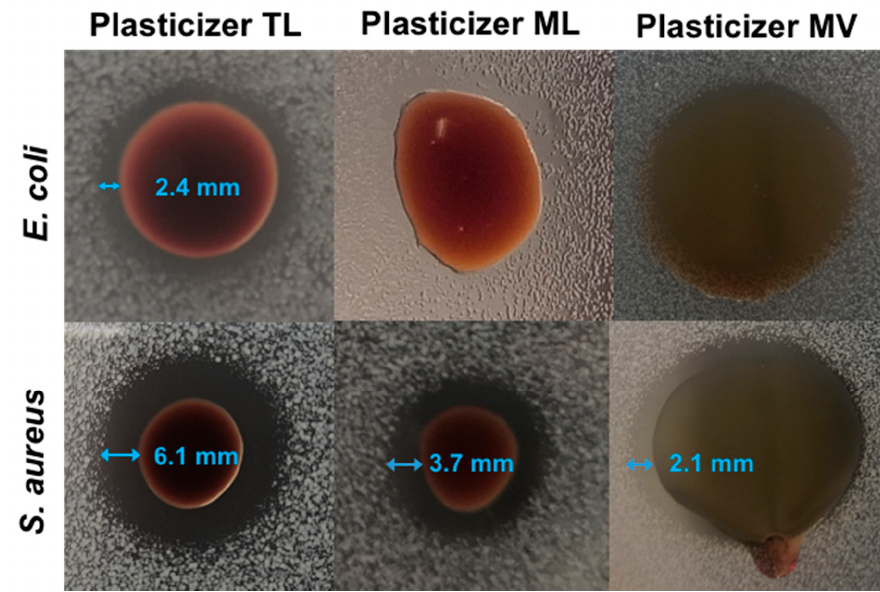
Figure 6. Zone of inhibition test on neat plasticizers against E. coli and S. aureus . Biomolecules 2020 , 10 , x FOR PEER REVIEW